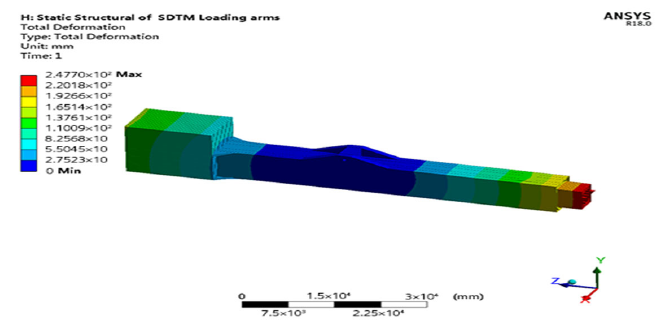
Figure 15. Static Displacement Nephogram of the Lifting Arm.